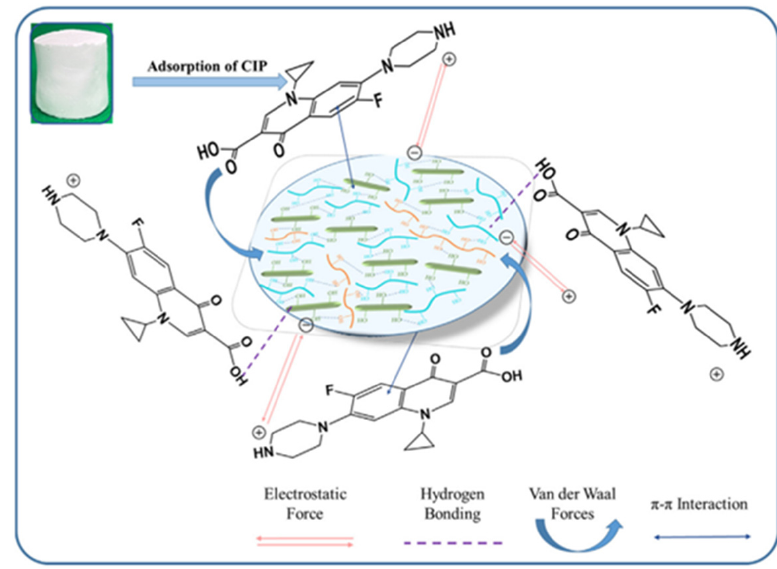
Figure 7. PVA-assisted CNCs/SiO 2 aerogel adsorption mechanism [141] .